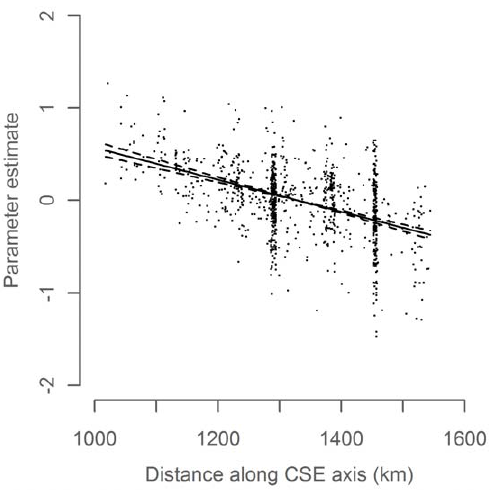
Figure 3. Day of Year parameter in the temperature model. Parameter estimate (solid line) with 95% confidence interval (dashed lines) and partial residuals (dots) relative to mean predicted value.